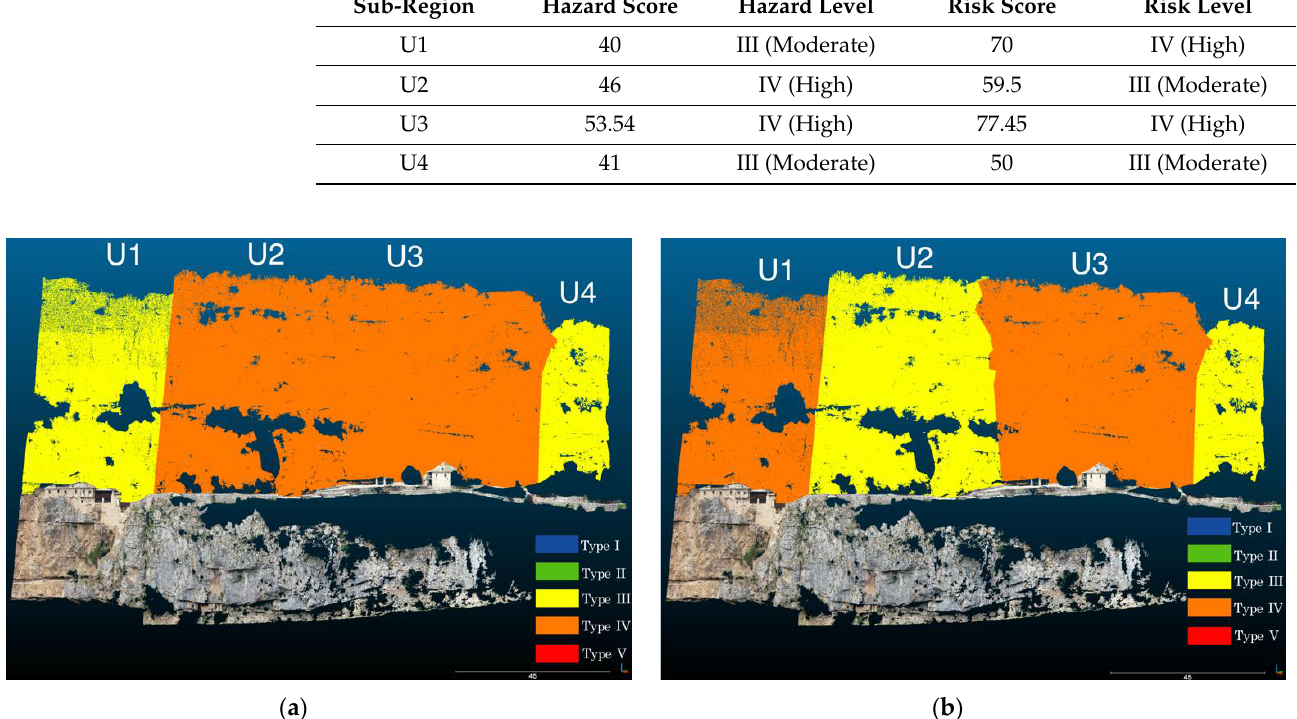
Figure 21. The visual interpretation of the results of the rockfall hazard and risk assessment with: (a) the hazard map and (b) the risk map along the cliff of Kipinas monastery.